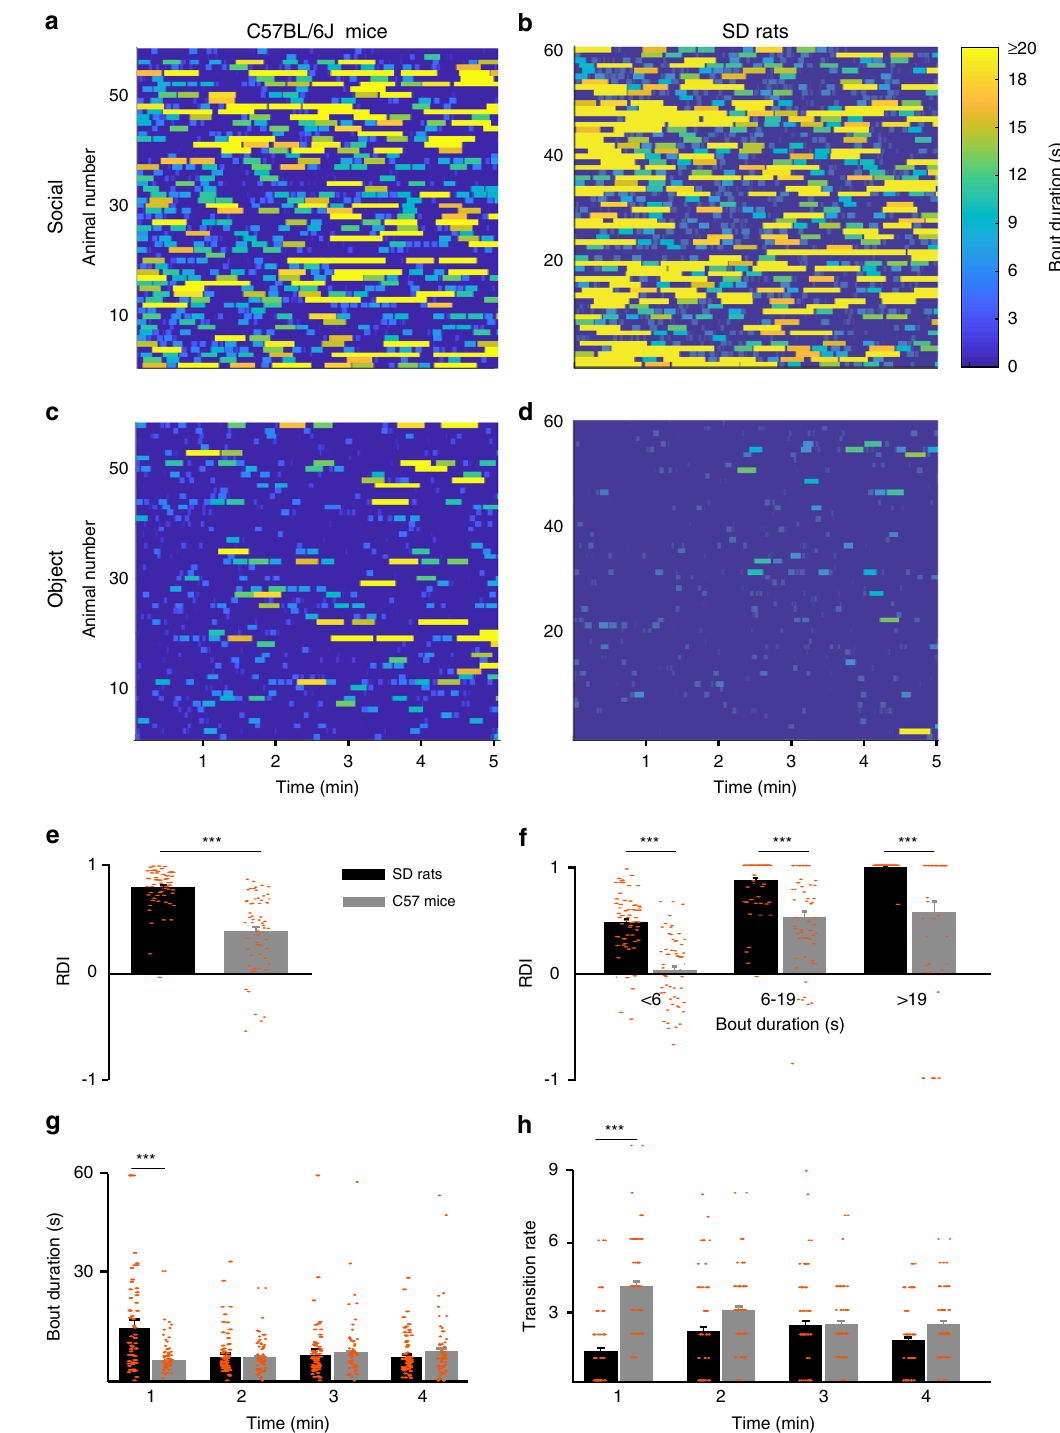
Fig. 2 Differences in social-preference dynamics are at the beginning of the test. a Heatmap (each row represents one animal) of the investigation behavior toward the social stimuli during the SP test, performed by C57BL/6J mice ( n = 58). b As in a for SD rats ( n = 60). c , d As in a , b for object stimuli. e Mean RDI (relative differential investigation) values for the SP test conducted with C57BL/6J mice and SD rats. f As in e , for the three categories of bout duration. g Comparison of mean bout duration values (averaged using 1-min bins) for the fi rst 4 min of the test, between C57BL/6J mice and SD rats. h As in g , for mean transition rate. *** p < 0.001, post hoc two-tail t test following the main effect. All error bars represent SEM. Source data are provided as a Source Data fi